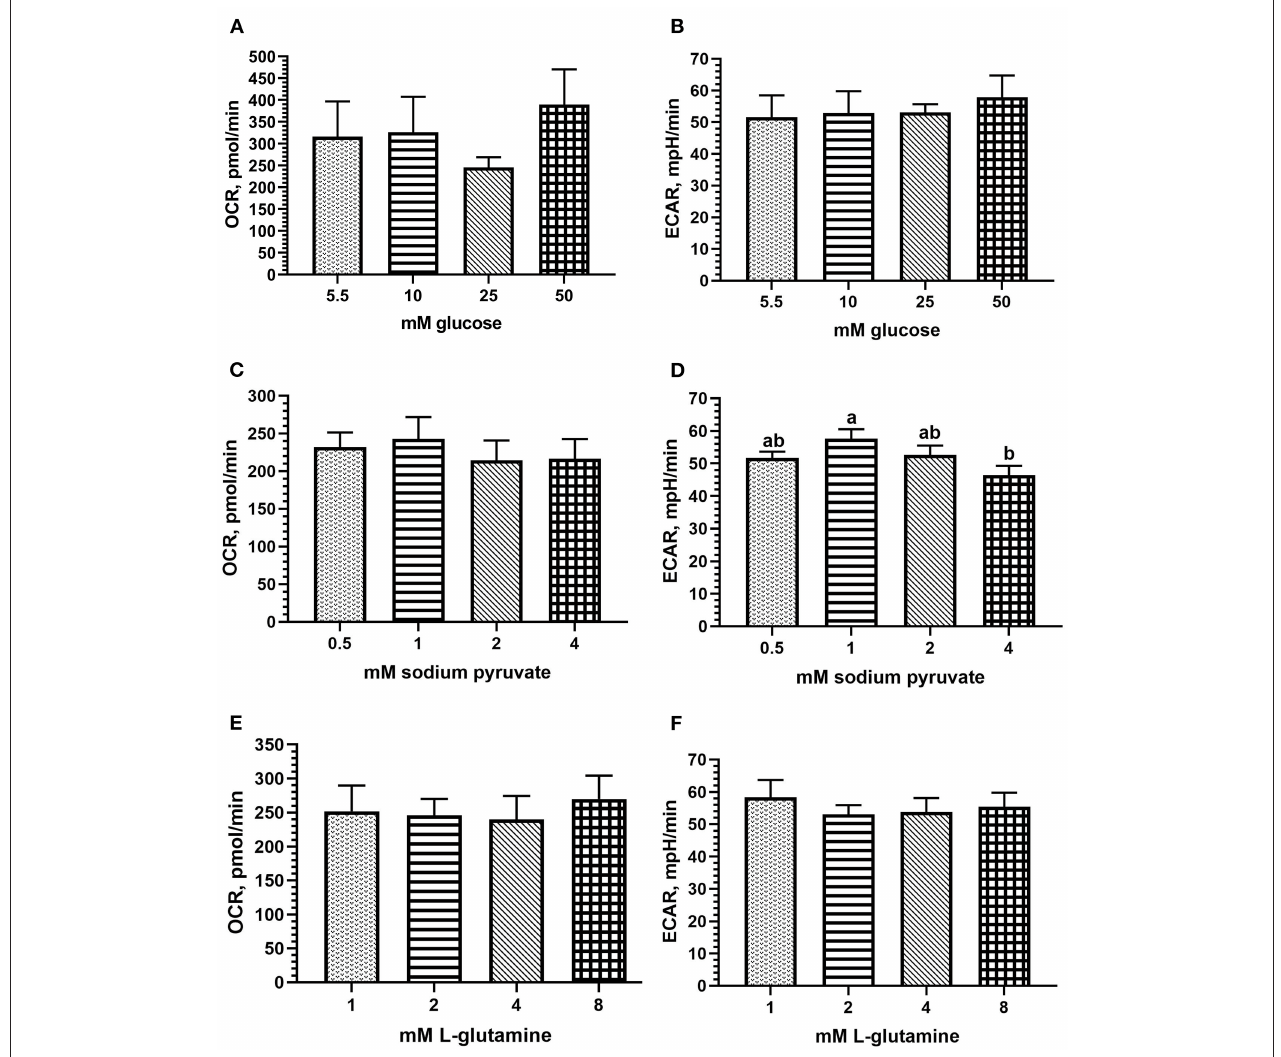
FIGURE 2 | Assay media substrate titrations for optimal results using fresh chicken PBMCs in the Seahorse Xfe24 Analyzer (Agilent) by main effect of substrate concentration, including (A) glucose; OCR, (B) glucose; ECAR, (C) sodium pyruvate; OCR; (D) sodium pyruvate; ECAR; (E) l-glutamine; OCR; and (F) l-glutamine; ECAR. All data are presented as LSMeans 1 (SEM). 1 Bars that do not share letters indicate means that are significantly different ( p ≤